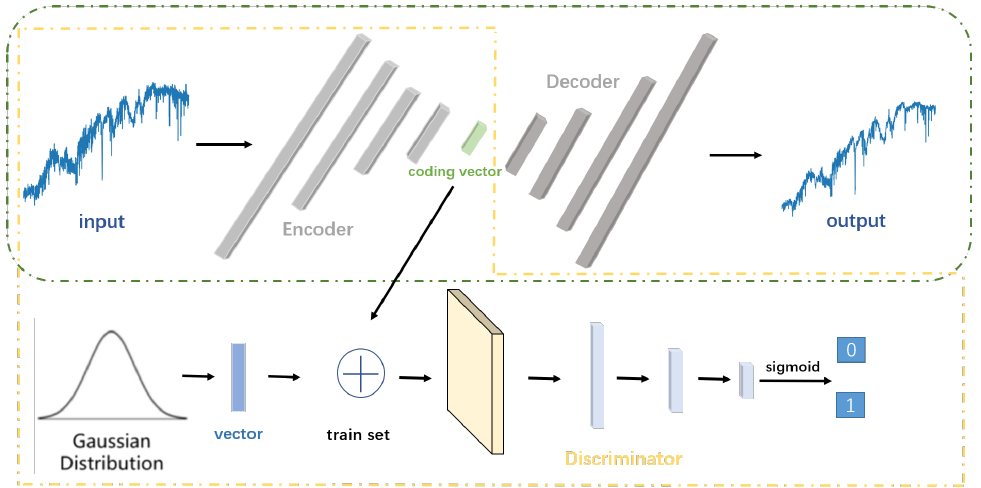
Figure 2. Structure of the Adversarial AutoEncoder (AAE). AAE is composed of an autoencoder and a discriminator. Green box part is autoencoder composed of an encoder and a decoder, and yellow box part is a GAN composed of a discriminator and an autoencoder. Firstly, spectral data are encoded and then decoded to generate reconstructed data similar to the input data. Secondly, encoding vector of input spectral data and a randomly selected vector which conforms to the normal distribution are used as false data and real data as input of the discriminator,